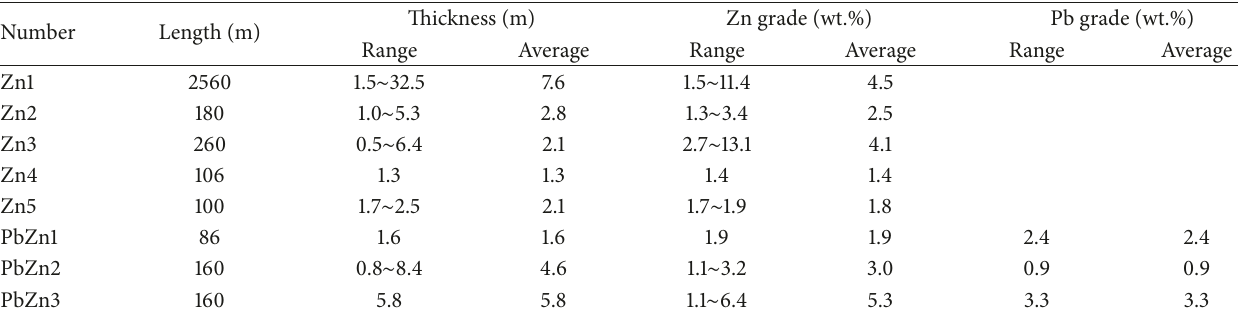
Table 1: Main characteristics of orebodies in the Nanmushu Zn-Pb